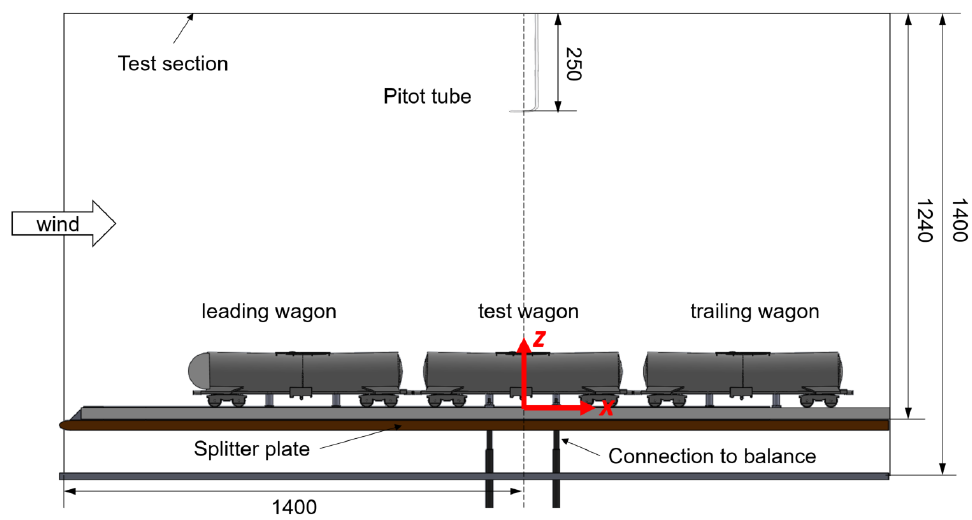
Figure 3. Train model with tank wagon configuration in the wind tunnel test section and coordinate system (dimensions in